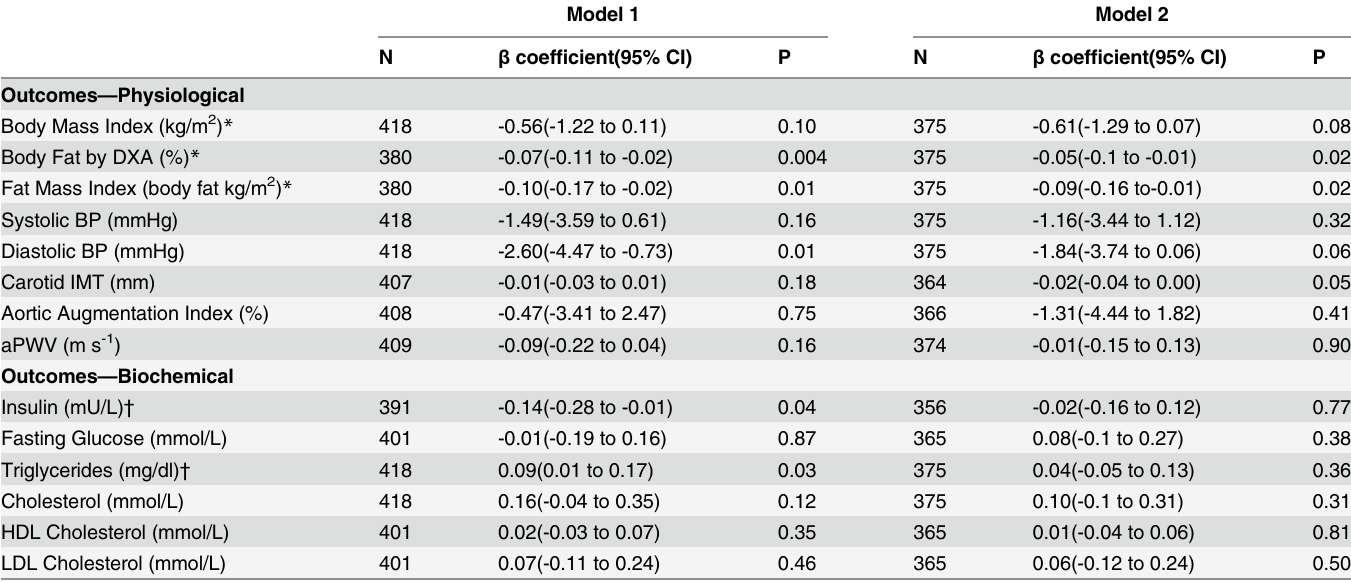
Table 4. Association of serum vitamin D (25(OH)D) † with cardiovascular risk factors in a sample of young Indian females from the Andhra Pradesh Children and Parents Study (n = 418) Ф ; 2009 –